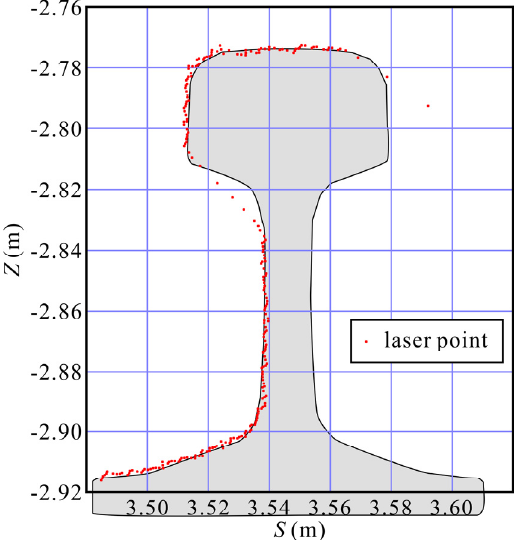
Figure 17. Laser points of the far rail of the scan line C